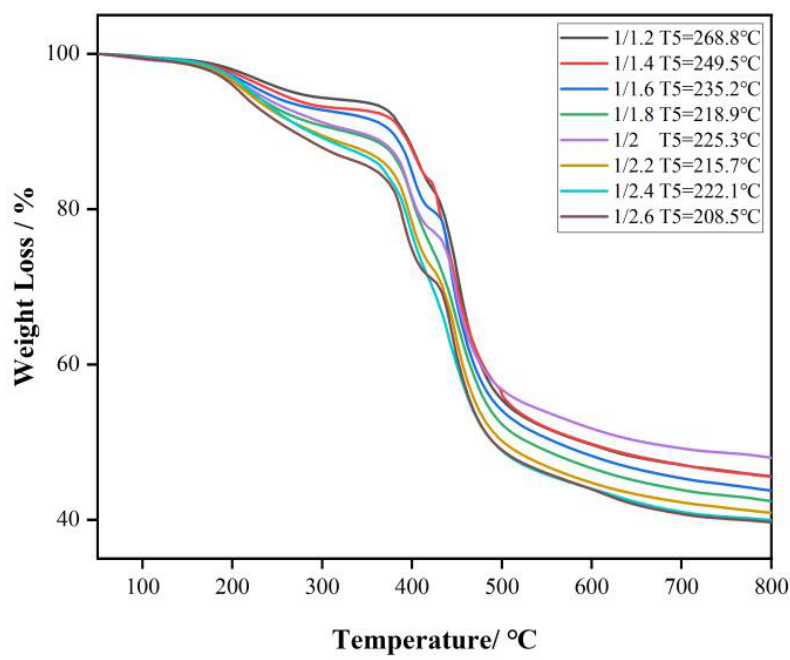
Figure 5. TGA thermograms of CF resins.